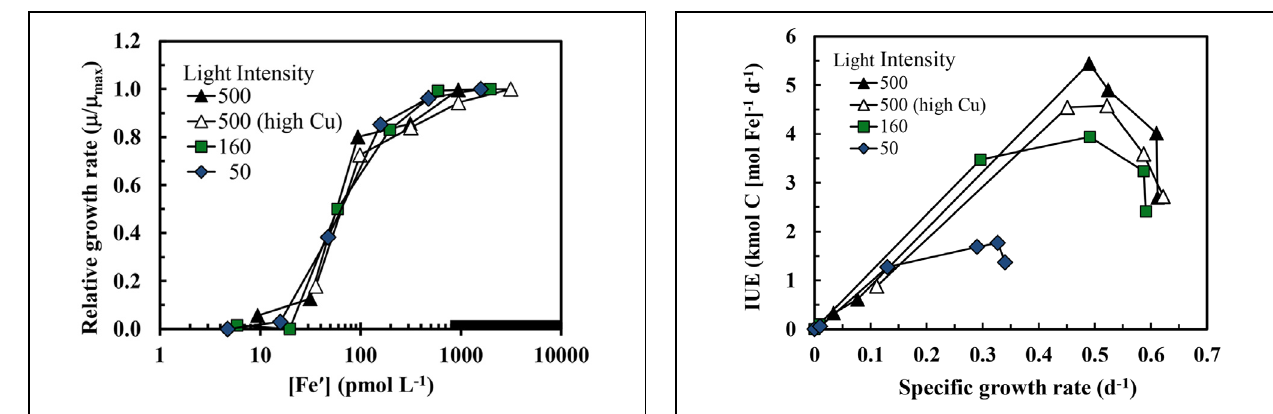
FIGURE 4 | Relationship between iron use efficiency (IUE) and specific growth rate in iron-limited and iron-sufficient cultures at three light intensities over a range of iron concentrations. The treatments and symbols are defined in brief on the figure and in detail in the legend of Figure 1 .